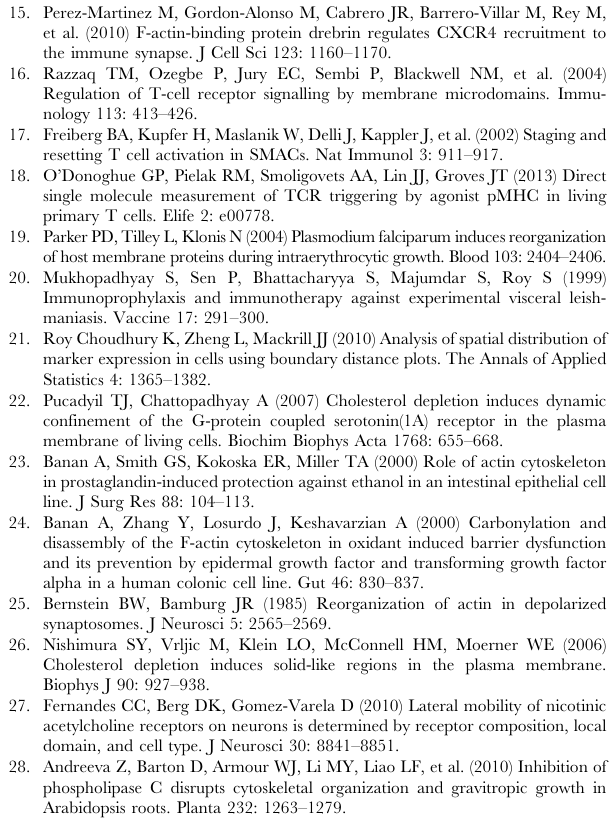
indicated by red rectangle. Figure S4 Fluorescence recovery of PLC d 1-GFP in N-M W (black circle), I-M W (red-square), I-M W -CL (green triangle) and I- M W -AL (blue triangle) after photo bleach. The data are expressed as % of recovery. (TIF) Figure S5 Immunoblot of actin. A) Expressions of F-actin. B) Expressions of total cellular actin. 10 6 /ml cell were lysed in a RIPA buffer. 100 m g of cellular protein were used to detect F-actin and total cellular actin. C. The densitometry ratio of F-actin/total actin. The analysis was done by image-J.